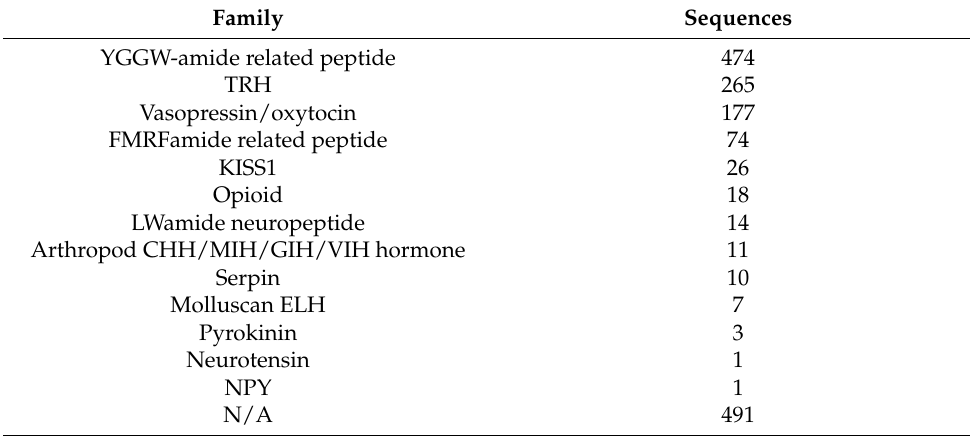
Table 1. Family of S. mekongi